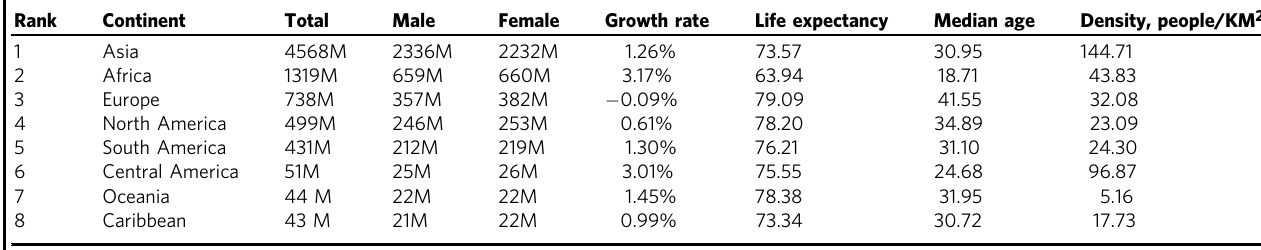
Table 2 Population data continent wise (mid 2020).